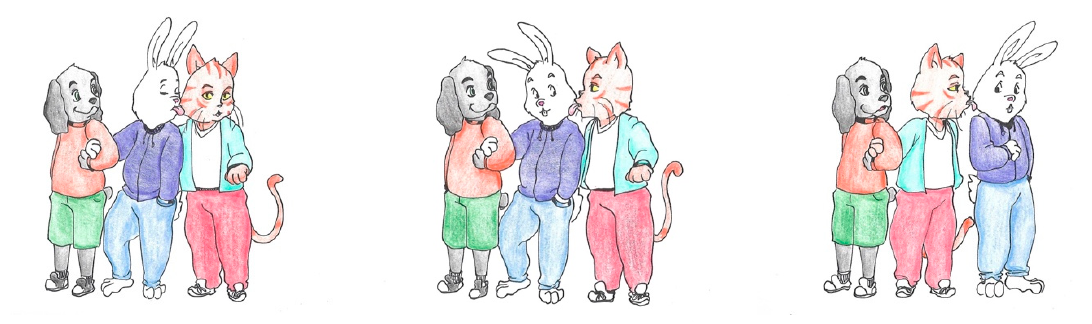
Figure A13. SRC stimulus 8.